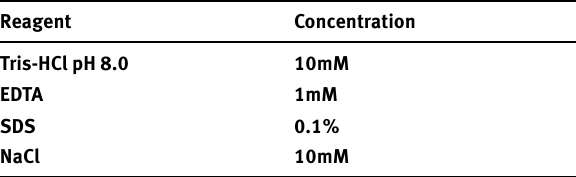
Table 1: Concentration and reagents of the lysis buffer Reagent